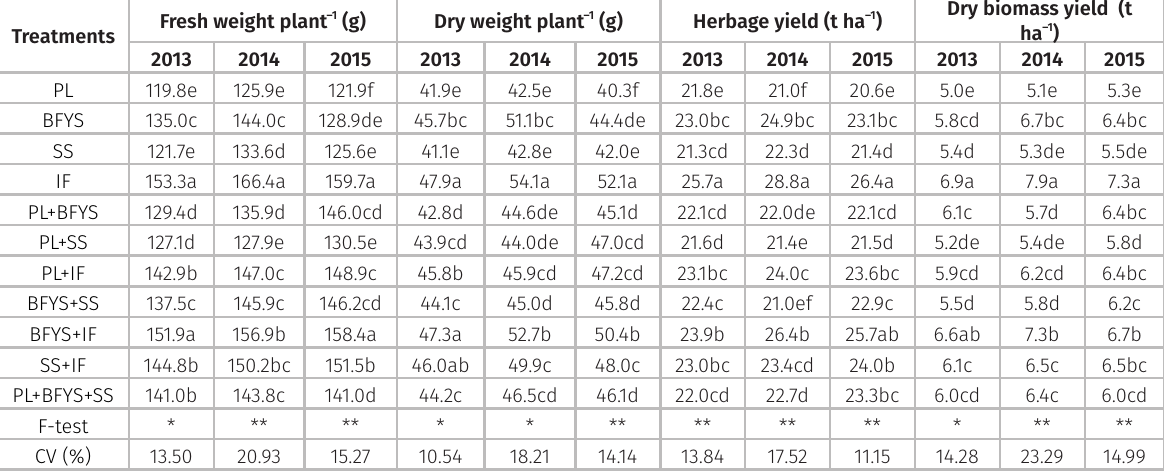
Table V. Yield attributes, herbage yield and dry matter biomass of soybean as influenced by different mineral and organic fertilization regimes under irrigated conditions of Faisalabad, Pakistan.